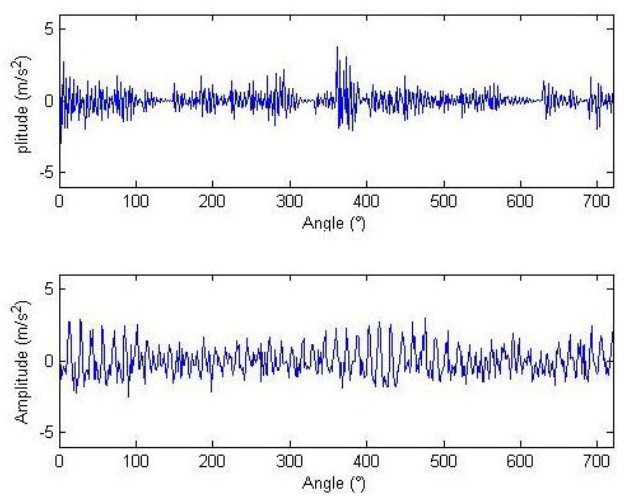
Figure 5. Impulse component (above) and harmonic component